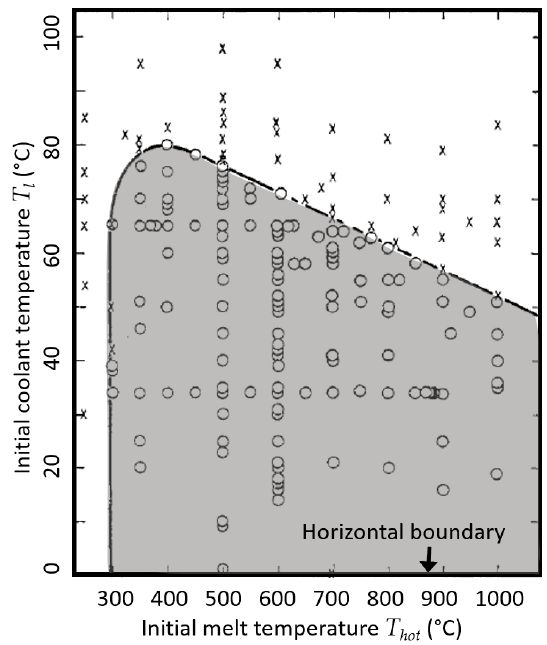
Figure 4. Representation of the temperature interaction zone (TIZ, grey area) for the interaction of 12 g of tin with distilled water (adapted from Reference [53]). 12 g of tin with distilled water (adapted from Reference